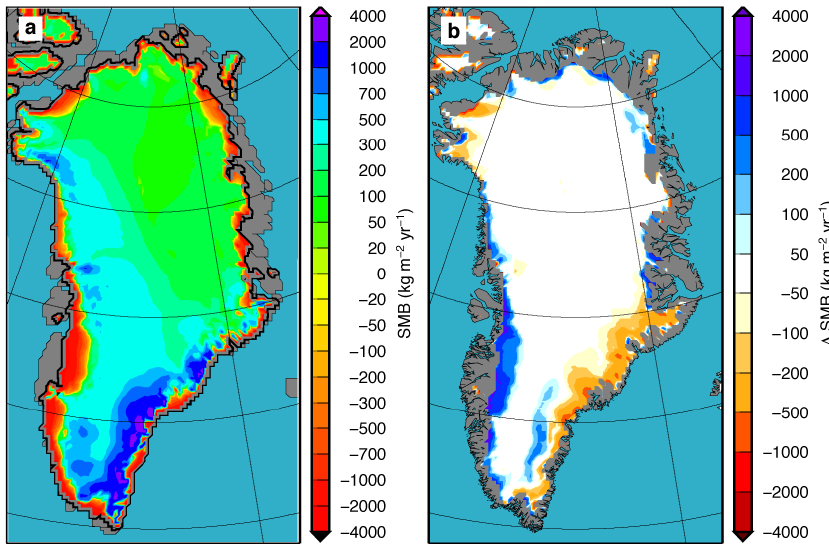
Fig. 10. (a) Steady-state SMB and (b) difference with present-day reconstructed SMB from Ettema et al. (2009) after a 100kyr experiment using present-day climate forcing and the SMB gradient